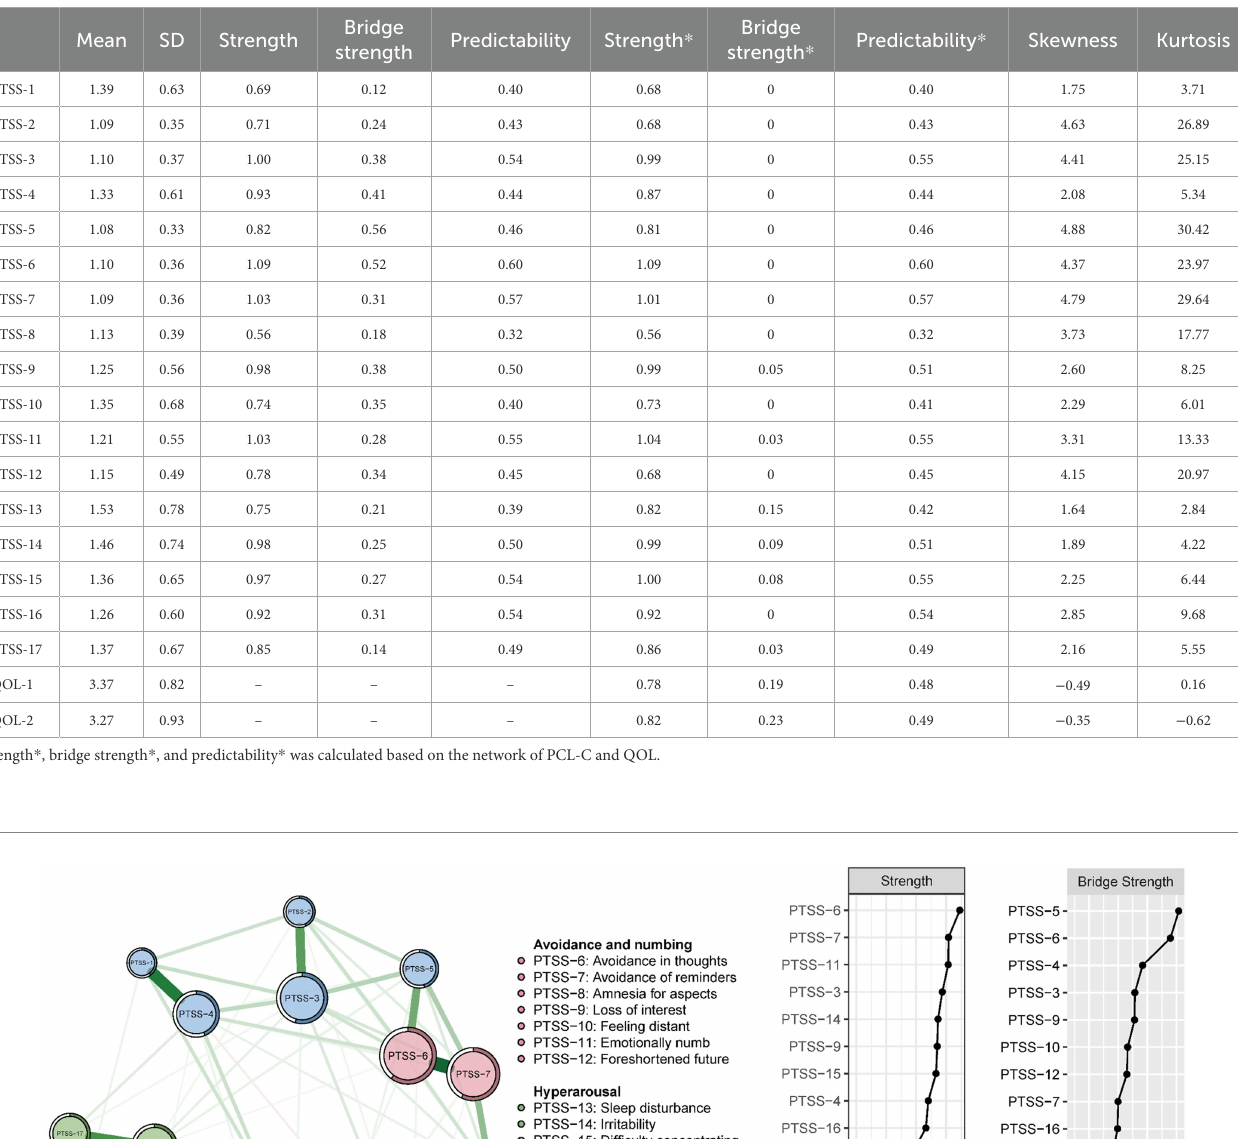
TABLE 1 Mean, standard deviation, strength, bridge strength, predictability, skewness, and kurtosis of the PCL-C and QOL items ( N =